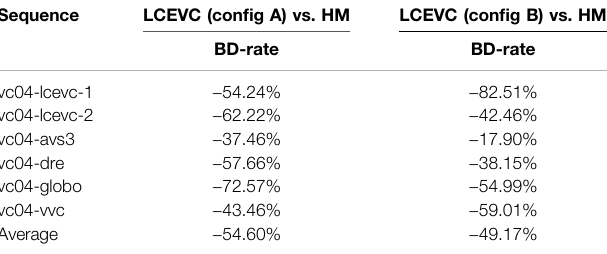
TABLE 2 | MOS scores and CI for HLG sequences. Sequence LCEVC (con fi g A) vs. HM